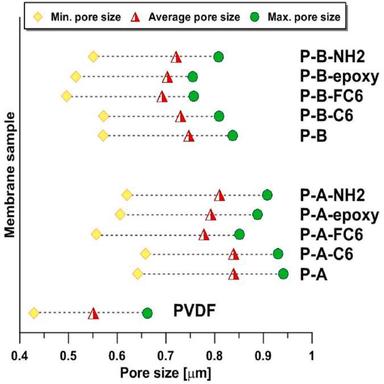
The pore size of pristine activated and functionalized PVDF membranes.